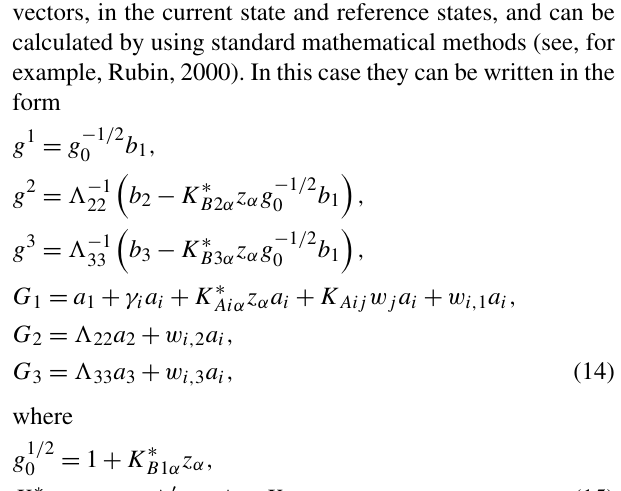
Throughout this paper, Greek indices take on values 2 and 3, Latin indices assume values 1, 2 and 3, and repeated indices are summed over their